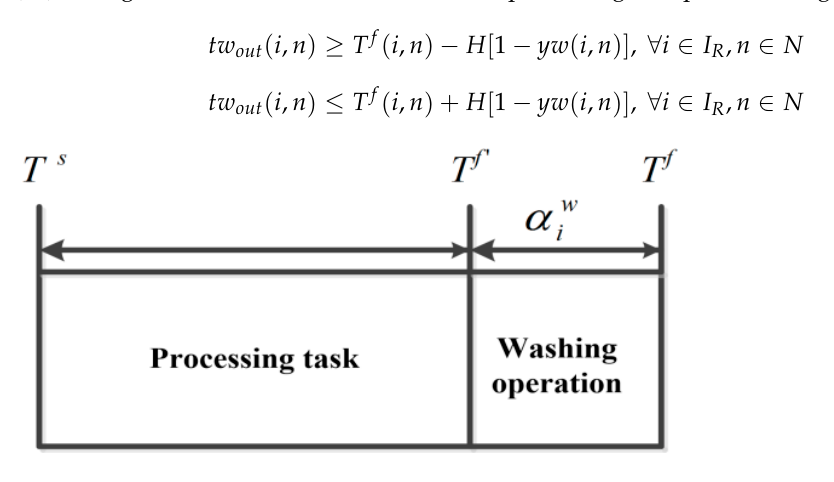
Figure 3. Washing sequence with no unit wait policy for washing units.